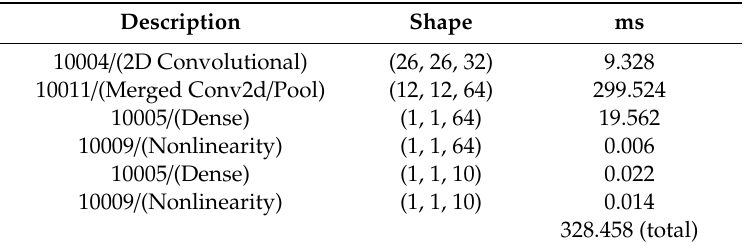
Table 7. Time contribution of each